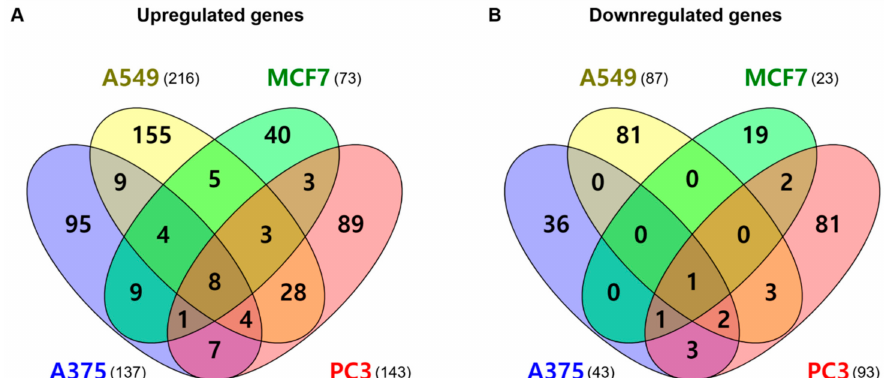
Figure 3. Venn diagram for the differentially expressed gene (DEG) list in four cell lines. ( A ) Upregu- lated genes and ( B ) downregulated genes. The crossing areas show the commonly changed DEGs. Venny website was used for drawing Venn diagrams (https://bioinfogp.cnb.csic.es/tools/venny/ index.html, accessed on 1 October